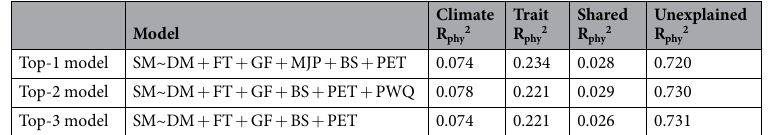
Table 5. Variance partitioning for the effect of traits and climate in explaining seed mass. n = 725. Note: SM: Seed mass; DM: Dispersal mode; GF: Growth form; MJP: Minimum juvenile period; BS: Breeding system; PET: Potential evapotranspiration; PWQ: Precipitation of warmest